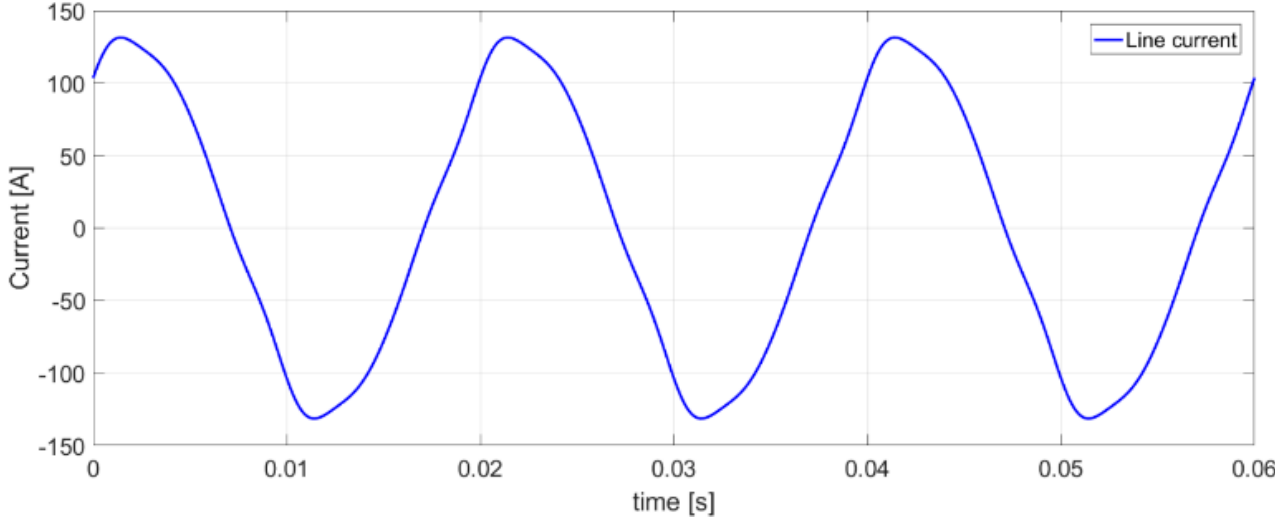
Table 4. List of RMS values of currents in CPC theory.